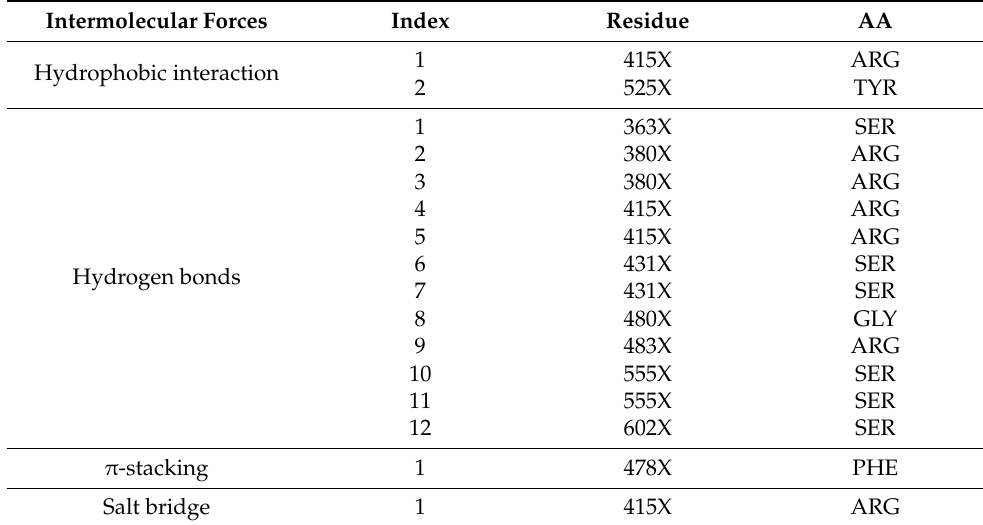
Table 3. Interaction force and the P2 binding site with the Keap1 active site (PDB ID: 2FLU). Intermolecular Forces